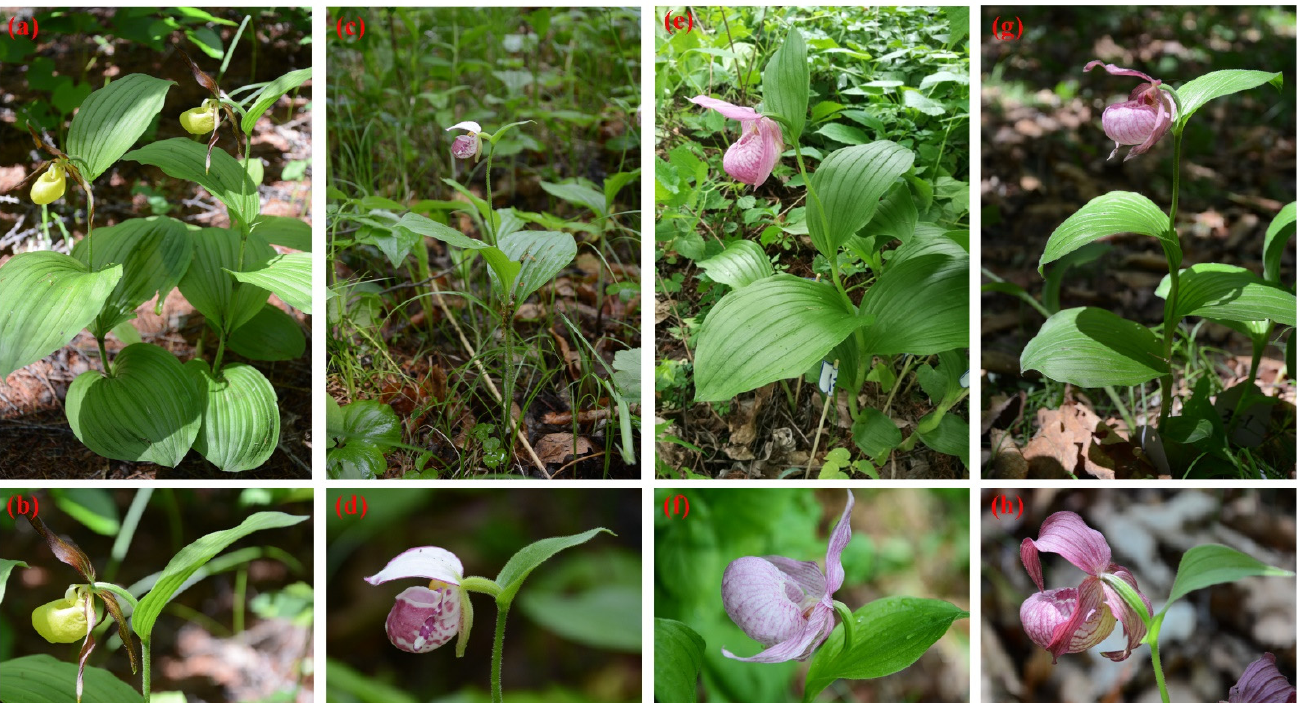
Figure 1. Wild Cypripedium calceolus ( a,b ), C. guttatum ( c,d ) , C. macranthos ( e,f ), and C. ×ventricosum ( g,h ) in Jixi.